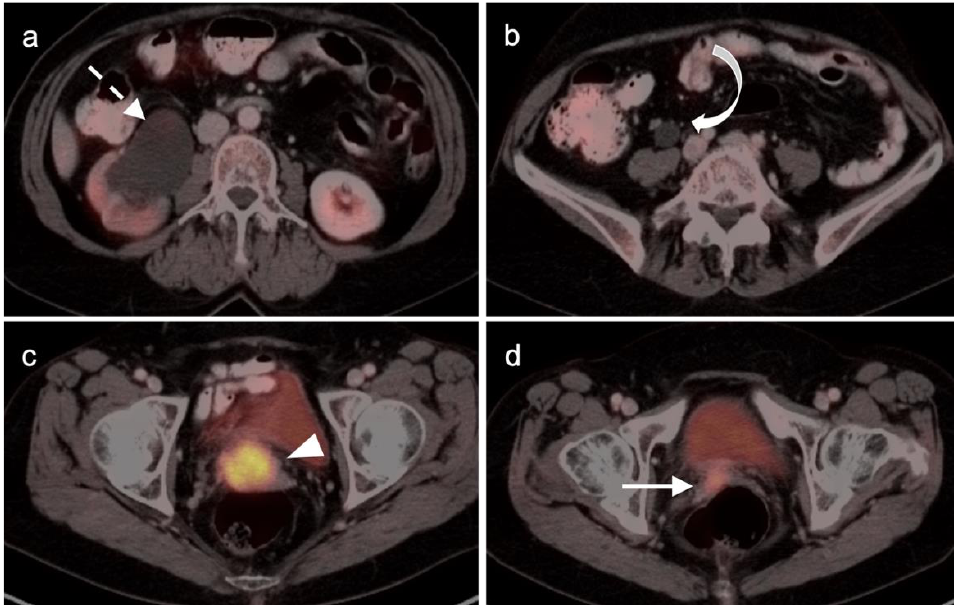
Figure 18. Stage IIIB cervical cancer by axial FDG PET-CT images of the pelvis ( a ) Hydronephrosis (white dashed arrow); ( b ) hydroureter (white curved arrow); ( c ) hypermetabolic cervical cancer (white arrowhead; ( d ) involvement of the right vaginal apex near the expected location of the right ureterovesicle junction (white arrow).